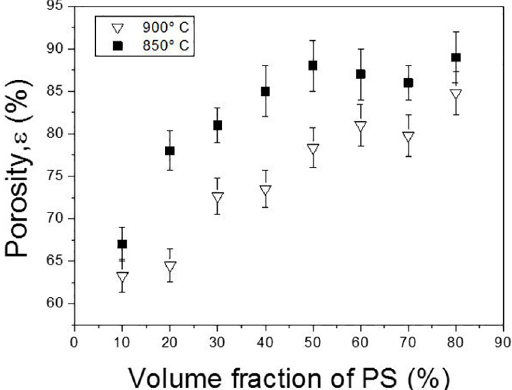
Figure 5. Influence of the volume fraction of PS spheres (from 10 to 80 vol.%) on the porosity of the vitrocrystalline foams fired at different temperatures (850 and 900 °C) for 30